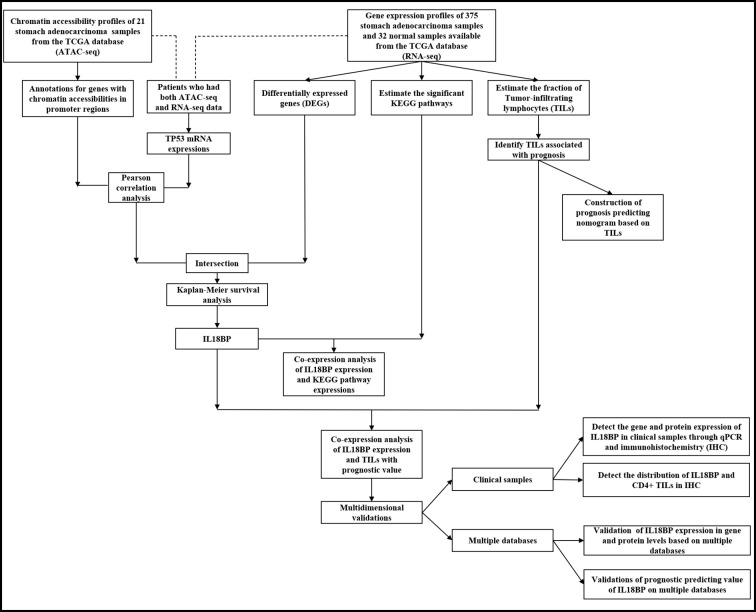
An overview of the workflow in this study.